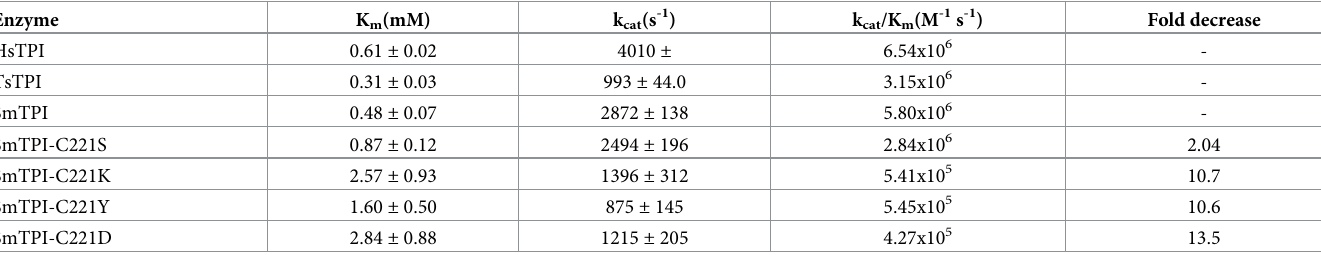
Table 1. Steady-state kinetic parameters of recombinant TsTPI and SmTPI in comparison to HsTPI. Enzyme K m (mM) k cat (s -1 ) k cat /K m (M -1 s -1 )